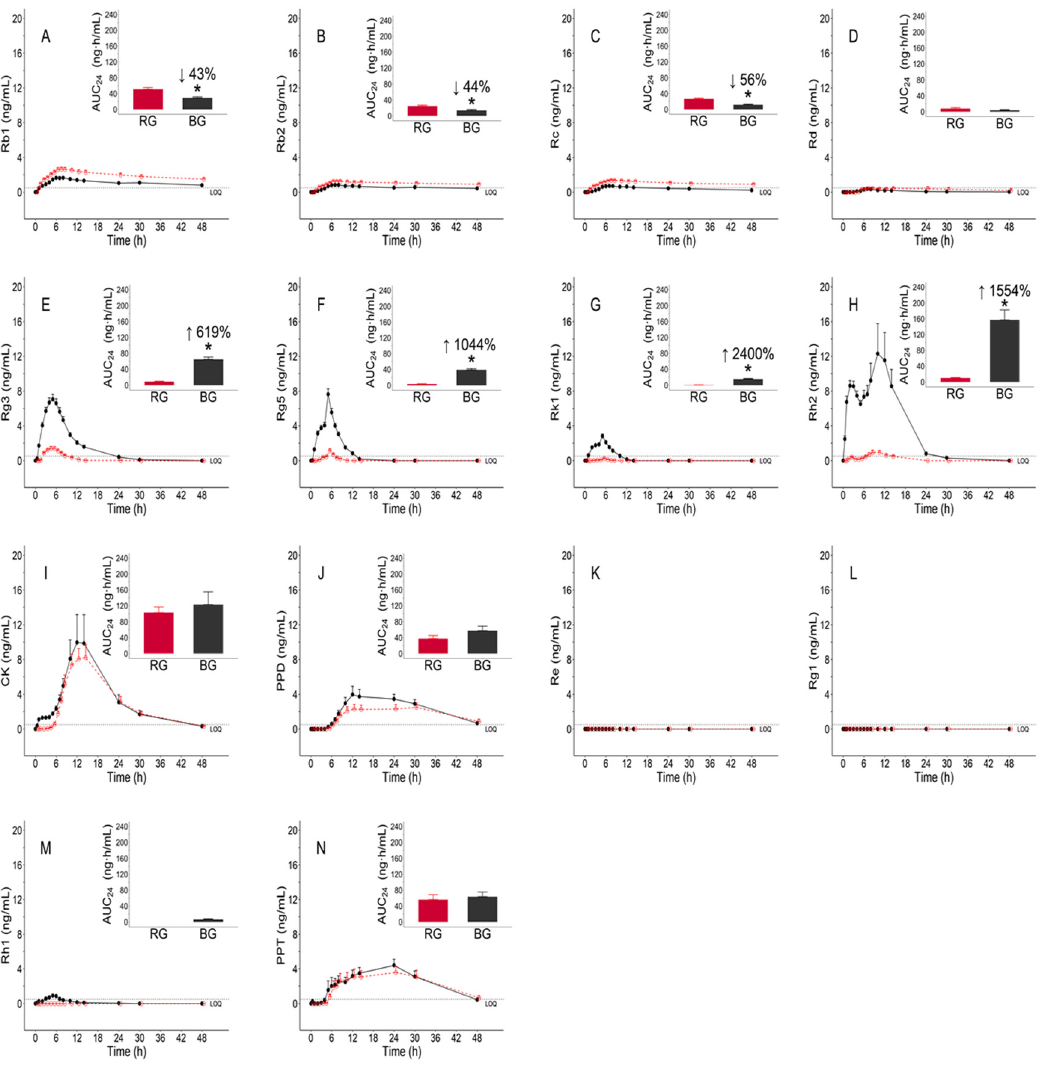
Figure 4. Mean ( ± standard error (SE)) plasma concentration–time profiles of ginsenosides after administration of a single dose of 9 g of red ginseng (RG) (red empty symbol and dashed line) and black ginseng (BG) (black filled symbol and solid line) extract. The inserted bar plot showing the mean ( ± SE) for the 0 to 24 h area under the concentration–time curve (AUC 24 ) of RG (red color) and BG (black color) extract: ( A ) Rb1; ( B ) Rb2; ( C ) Rc; ( D ) Rd; ( E ) Rg3; ( F ) Rg5; ( G ) Rk1; ( H ) Rh2;